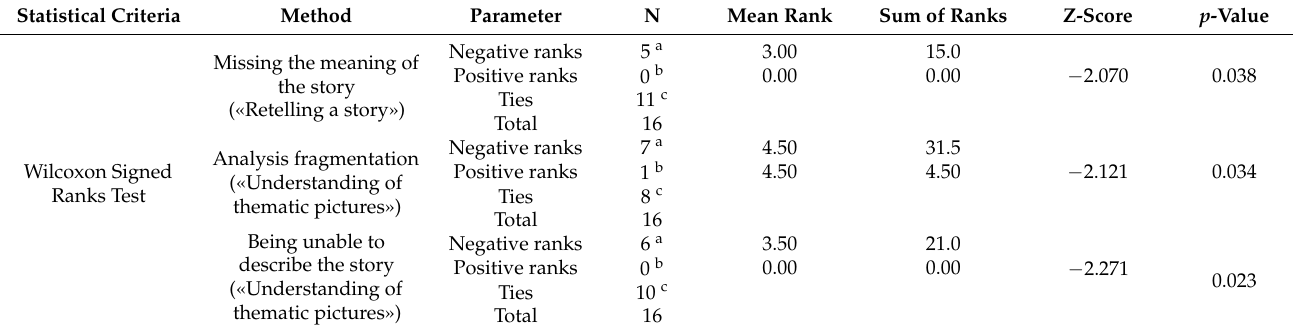
Table 5. Results of the statistical analysis of subscales which differed significantly before and after the training ( p ≤ 0.05). Statistical Criteria